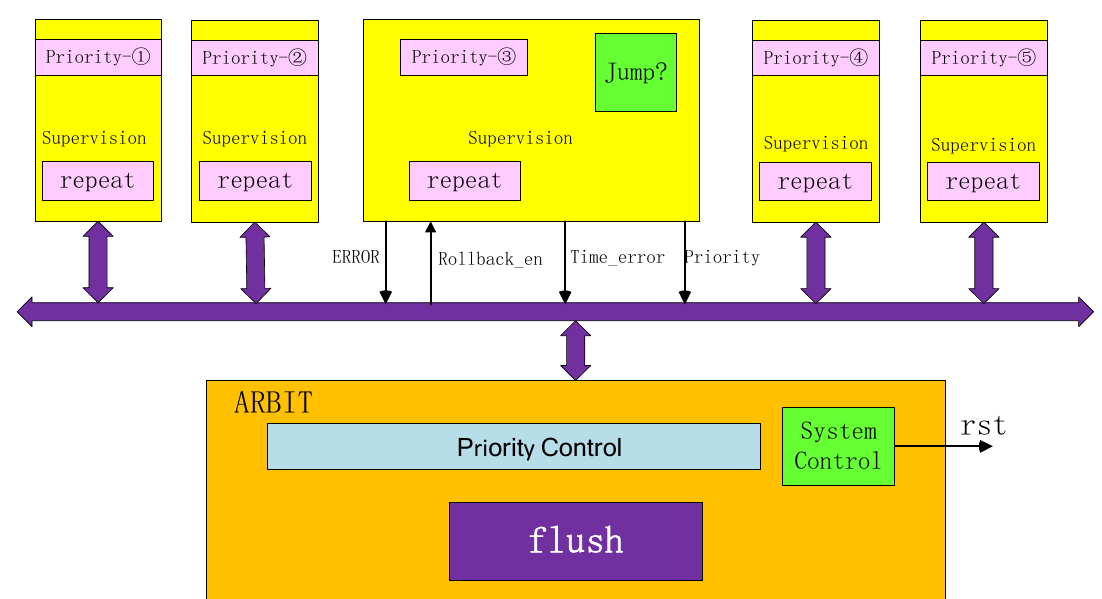
Figure 15. The relationship between the arbiter and the supervisory module. The yellow part of the figure shows the SUPERVISION modules distributed between the 1–5 stages of the pipeline, which are distributed from left to right to monitor the error conditions of the 1–5 stages of the pipeline in turn. The SUPERVISION module summarizes the collected error signal, priority, and instruction type to the ARBIT module. The ARBIT module determines the rollback strategy through internal judgment and sends the rollback command back to each SUPERVISION